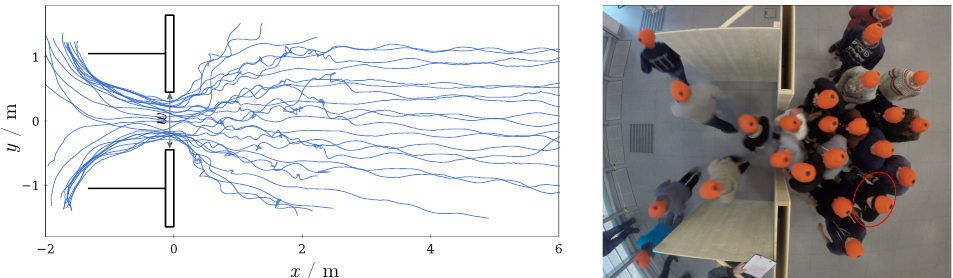
Figure 7. ( Left ) Schematic overview of the experimental setup for a bottleneck width of w = 1m. The walls are drawn in black and the camera trajectories of all participants in blue. ( Right ) Overhead camera view of the corresponding experiment with people wearing orange caps with black dots. The red encircled person is wearing the IMU